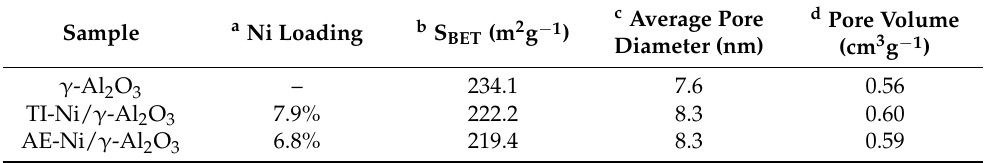
Table 1. The physical parameters of γ -Al 2 O 3 and catalysts prepared by different methods.